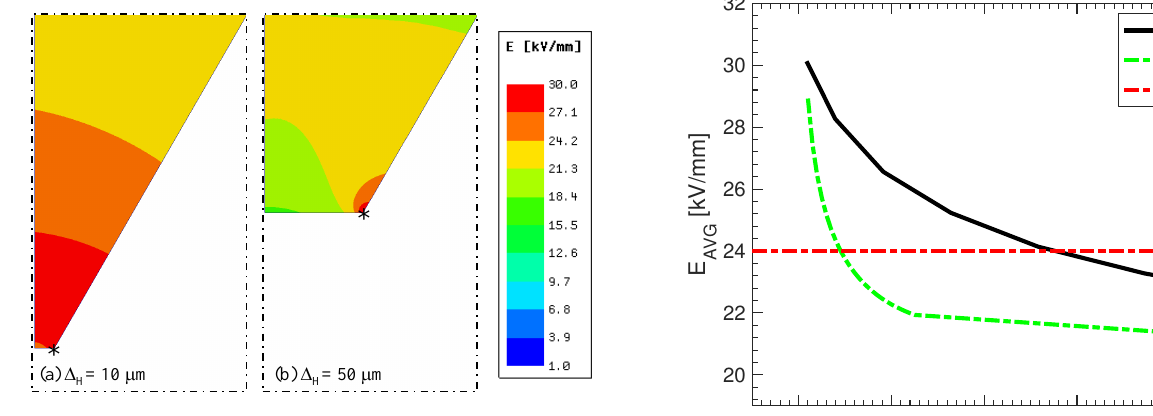
Figure 12: Electric field magnitude for truncated-chamfer singularities; (a) ∆ H =10 µ m, (b) ∆ H =50 µ m. The singu- larity points, in correspondence to which the control vol- umes are centered, are indicated by the asterisks (*). The colormap legend ranges from 1 kV/mm to 30 kV/mm.